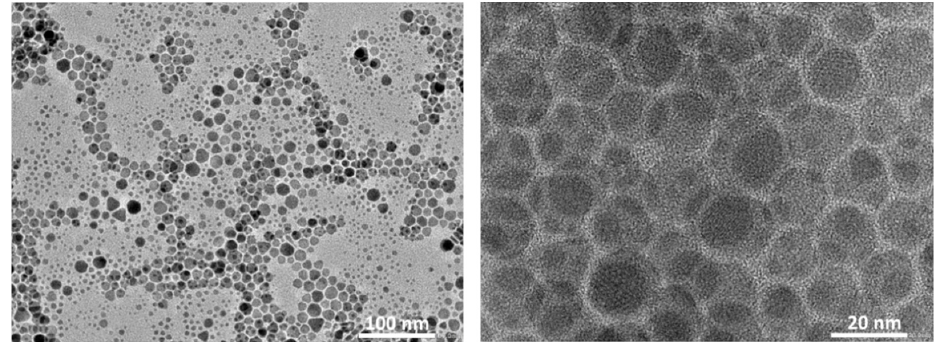
Figure 6. TEM images of CuZnS QDs at low ( left ) and high ( right ) magnification.